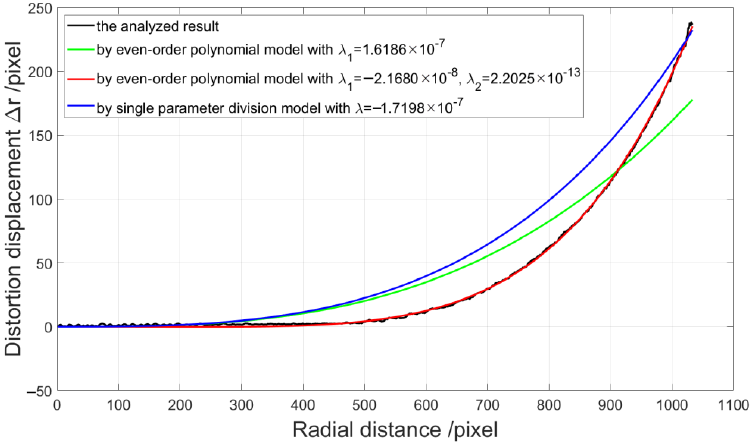
Figure 16. Radial distortion displacement and curve fitting results.